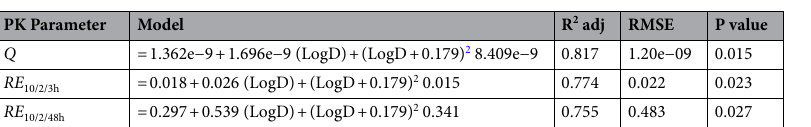
Table 3. Multiple linear regression of PK parameters and molecular descriptors as explanatory variable. Only statistically significant models are shown. R 2 adj: R 2 adjusted. RMSE: root mean square error. P value (< 0.05).